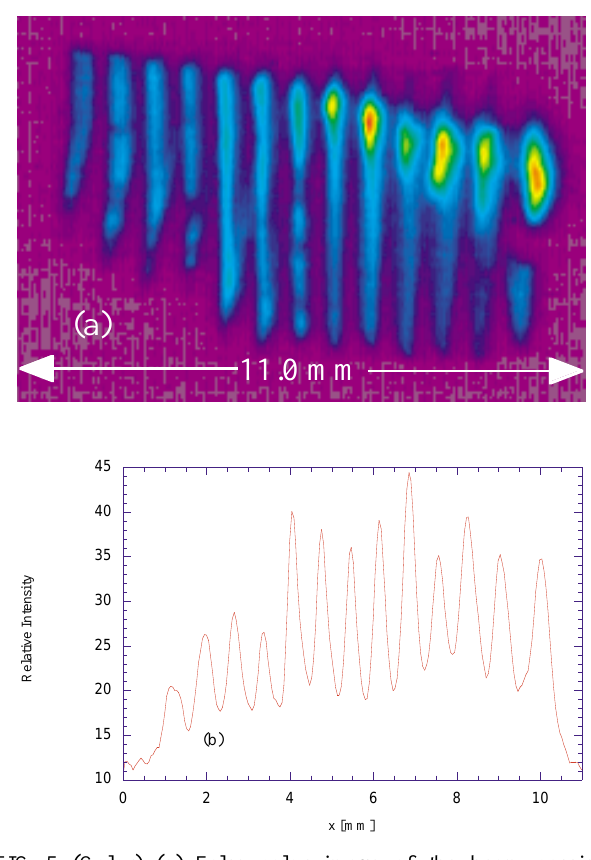
FIG. 5. (Color) (a) False color image of the beam passing through the collimating slits. (b) Intensity graph found by summing the vertical pixel values at a given horizontal position. The normalized horizontal emittance calculated from this plot is 6.9 6 0.7 mm mrad.